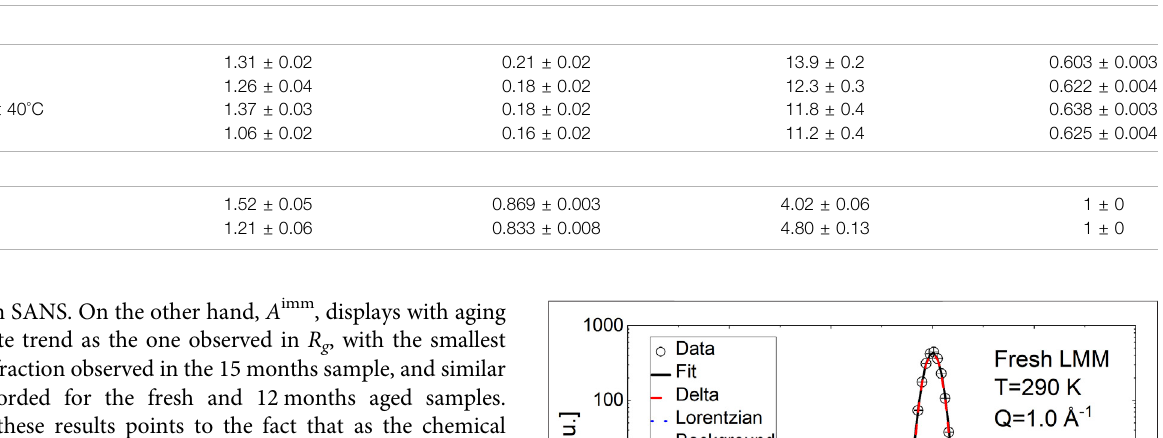
TABLE 3 | Fitting results of the Q dependence of the parameters extracted from the QENS spectra. Rg (Å)